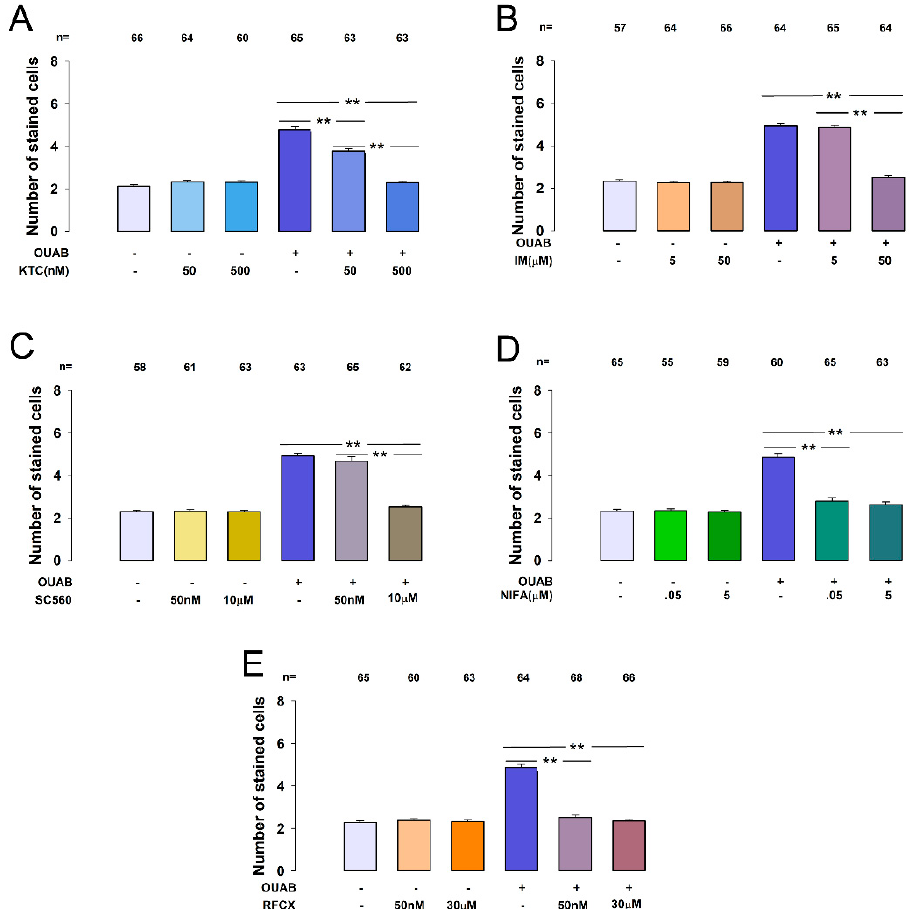
Figure 4. COX inhibitors suppress CM-induced enhancement of GJIC in MDCK-I cells. ( A – E ) are bar charts comparing X SC ( ± SE) in the experimental condition indicated at the bottom of each bar. Each bar chart shows the effect of a distinct COX inhibitor ( A ) ketorolac (KTC), ( B ) indomethacin (IM), ( C ) SC-560, ( D ) niflumic acid (NIFA), ( E ) rofecoxib (RFCX). (**) indicates statistically significant difference ( p < 0.001) of the groups that separates the lines. The values above bars indicate the number of repetitions.